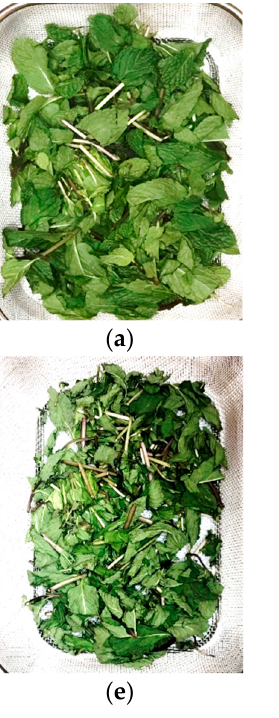
Figure 9. Mint color retention during drying process using indirect solar dryer. ( a ) Fresh, MC = 71%. ( b ) 1 h, MC = 60%. ( c ) 2 h, MC = 52%. ( d ) 3 h, MC = 35%. ( e ) 4 h, MC = 23%. (f) 5 h, MC = 18%. ( g ) 6 h, MC = 15%. ( h ) 6 h, MC =13%. The independent variables (time and drying methods) used to dry mint herb show significant differences in color parameter changes for L*, a*, b*, chroma, and DGCI values ( p <0.05). However, no significant difference was observed in the hue values ( p > 0.05). Fig ‐ ure 10 shows the color data in terms of the L*, a*, and b* values of fresh and dried mint leaves. The L* values of the mint leaves decreased by drying. The L* values of the sun ‐ dried and shade samples were lower among the indirect solar dying, which was closer to the L* values of the fresh sample ( p < 0.05). The a* values of the mint leave increase during drying from dark green to light green (negative = green), but the direct sun dying sample reaches a high value (positive = red). The b* values of the mint leave decrease within the drying process. Direct sun drying shows a lower b* value. Figure 11 shows that indirect solar drying has lower degradation compared with other methods. The lightness was de ‐ creased by 29%, 18%, and 22% in indirect solar, direct sun, and shade drying, respectively (Figure 10a). Moreover, the drying process influenced the green value of all drying meth ‐ ods, but the indirect solar dying has less effect, and the green retention reaches 99% com ‐ pared with direct sun drying (64% (Figure 10b)). Furthermore, the yellow value was weak ‐ ened by 36% in indirect solar drying, 44% in direct sun drying, and 59% in shade drying (Figure 10c). The hue and Chroma were reduced by 39% and 13% in indirect solar drying, respectively (Figure 10d,e). Therefore, the color difference showed a significant change in direct sun drying compared with indirect solar drying due to drying temperature and time (Figure 10f). Therdthai et al [25] reported that the fresh mint had L* = 35.39 ± 1.36, a* = 10.23 ± 0.88, and b* = 26.92 ± 1.01, respectively, which confirmed the current study. Fur ‐ thermore, Therdthai et al. [25] stated that the best ‐ dried mint has a green ‐ yellow color that is reached by increasing L*. High temperatures may cause the magnesium in chlorophyll to be replaced by hydrogen and transform chlorophylls into pheophytins [26]. Although changes in color during drying are inevitable, the changes in color could be reduced by optimizing the drying process parameters, such as drying temperature, time, and air ve ‐ locity.